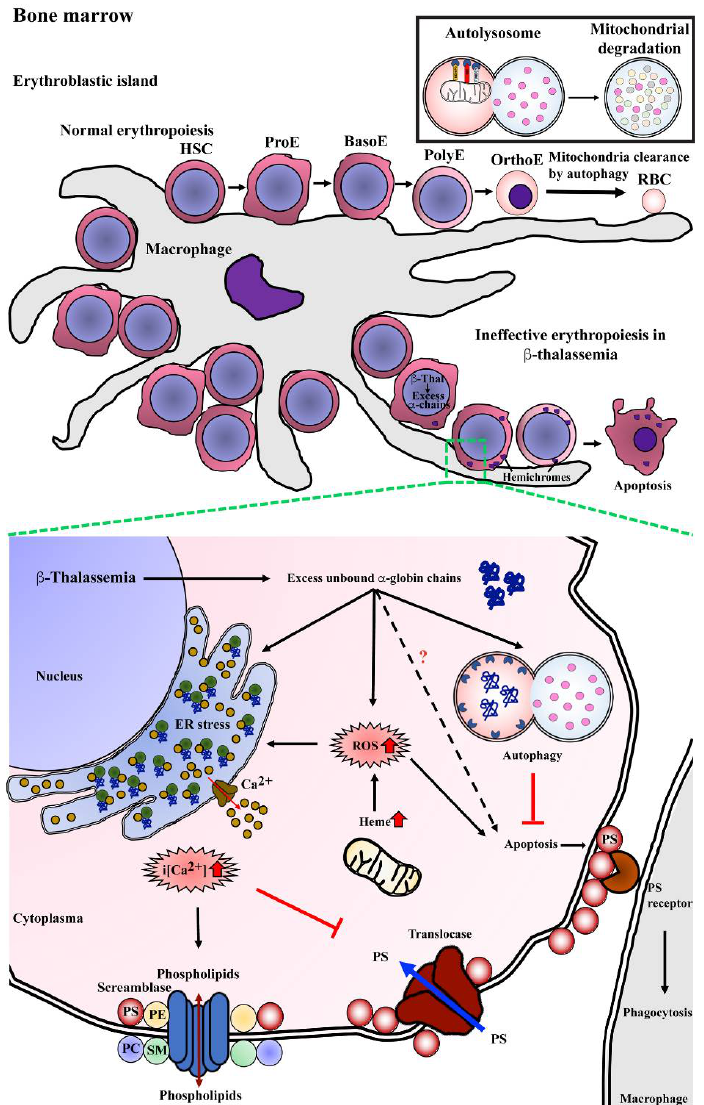
33342 + erythroblasts have also been detected in cluster of differentiation (CD)45 - bone mar- row cells of β - thalassemia patients [3] . In addition, increased phosphatidylserine ( PS )- exposing basophilic normoblasts and polychromatophilic normoblasts have been re- ported in β - thalassemic bone marrow erythroblasts from both patients and from a mouse model [3,26,28] .